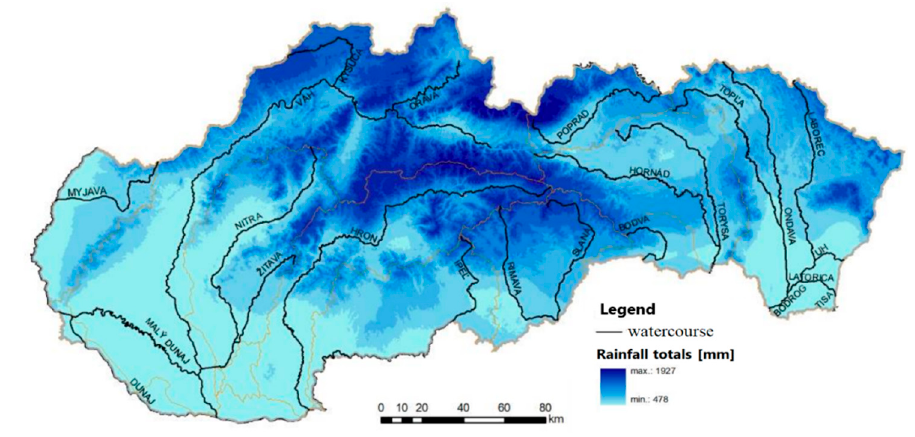
Figure 3. Total atmospheric precipitation (mm) in Slovakia in 2019 [54].